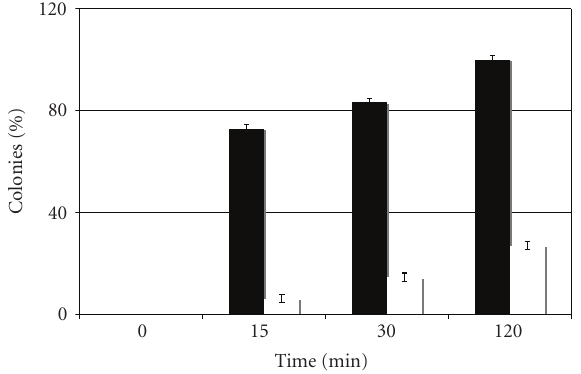
Figure 5: The number of colonies obtained from extension by hPol η of a control sca ff old (black) was compared with the G[8,5- Me]T sca ff old (white) at di ff erent time points in the bar graph. The number of colonies obtained from the 120 min extension of the control 36-mer was arbitrarily considered 100%. The zero time point showing no colonies ensures that colonies only originated from the extension